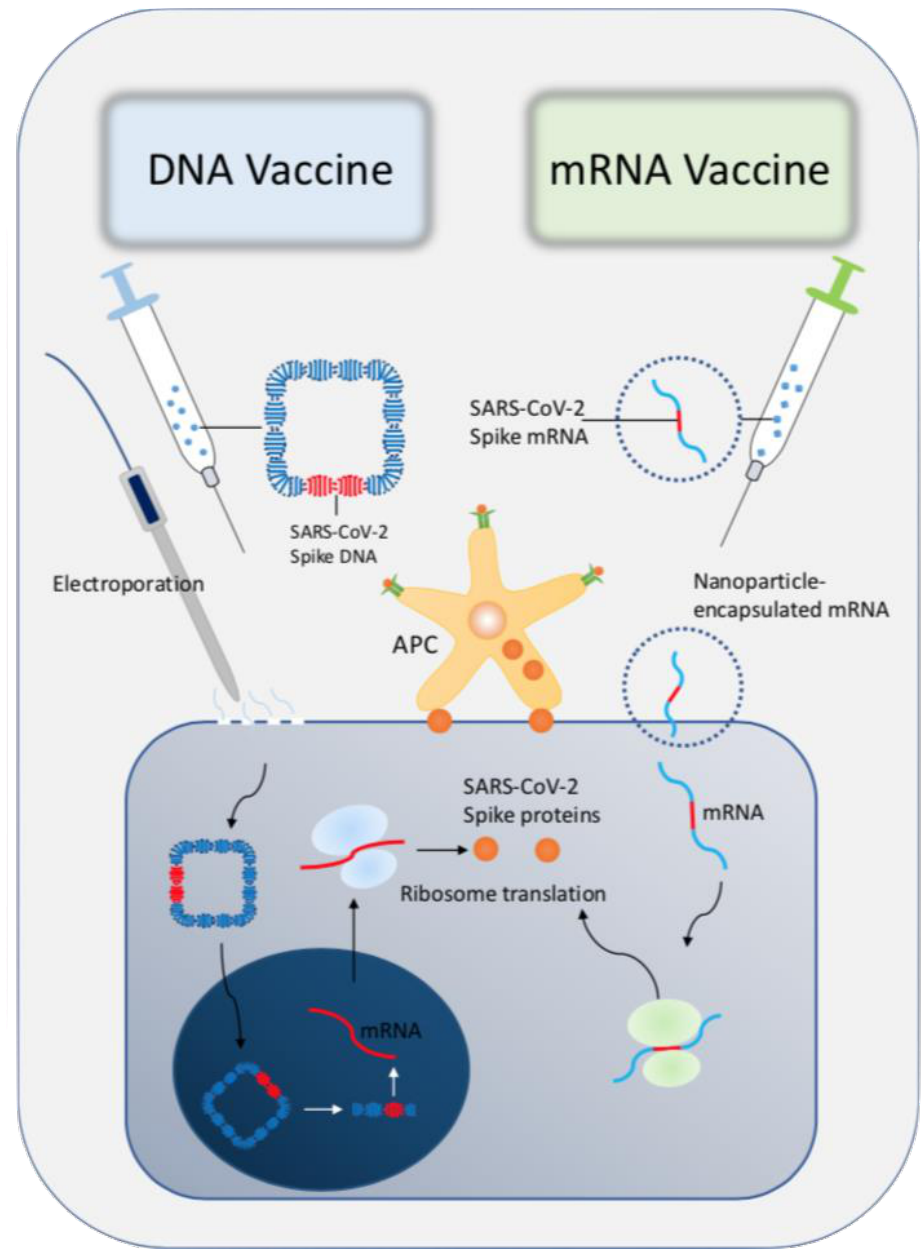
Figure 1. Schematic graph of the comparison between DNA and mRNA vaccine in terms of mecha- nisms. DNA vaccine is a circle DNA which contains the spike gene of SARS-CoV-2. After electro- poration, cell membrane permeation will be increased, allowing DNA enter into cytoplasm thereby reaching to the nuclear. Subsequently, DNA will be translated into mRNA, which will be further translated into SARS-CoV-2 spike proteins and express on cell membrane. Nanoparticle-encapsulated mRNA encoding SARS-CoV-2 antigen will be integrated into cytoplasm. The spike mRNA utilizes ribosome and bases to translate spike proteins, which express on the cell membrane. The membrane spike protein will be recognized by antigen presenting cell (APC) thereby activating immune